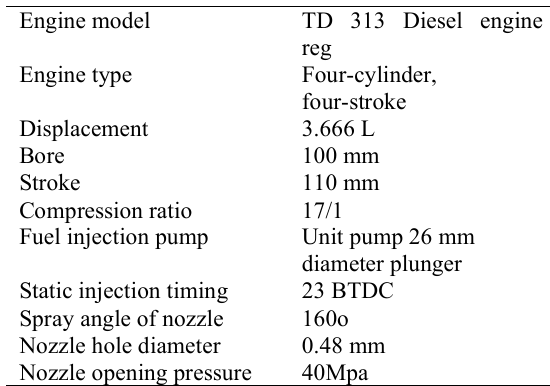
Fig. 2. Gas Analyzer.